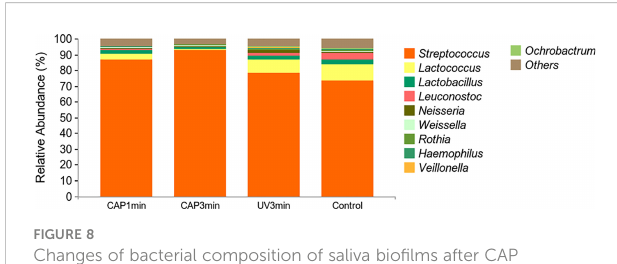
FIGURE 8 Changes of bacterial composition of saliva bio fi lms after CAP treatment. (Average relative abundance –